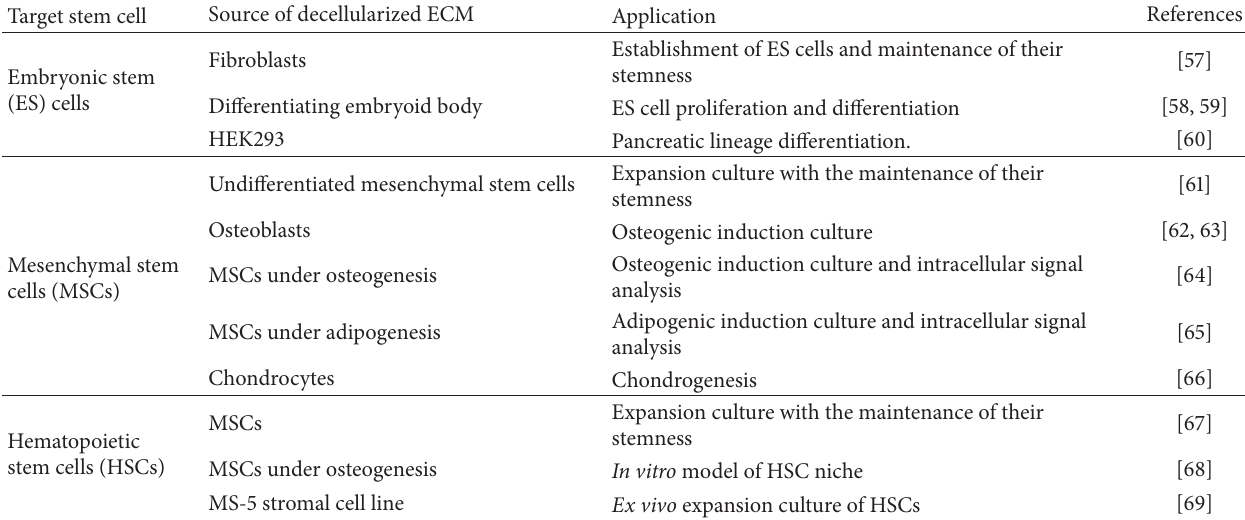
Table 2: Partial list of cell-derived decellularized ECM for stem cell